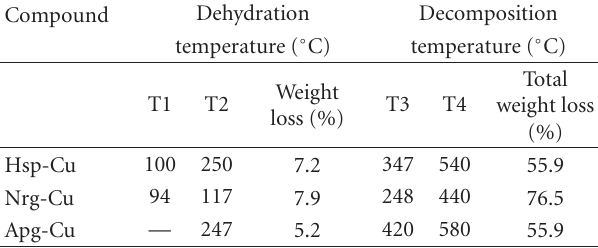
Table 2: Thermal analytical data for